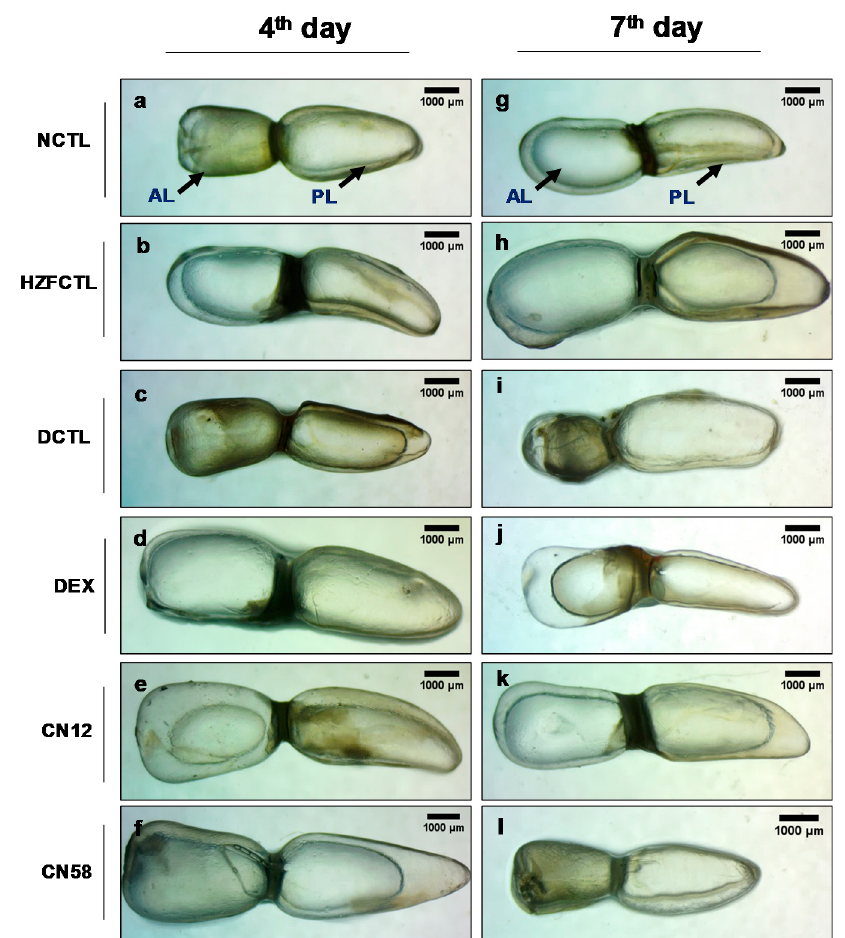
Figure 4. Coronil reduces SARS-CoV-2 induced swim bladder structural abnormality and edema. (Normal control at 4th day ( a ), HZFCTL at 4th day ( b ) and NCTL at 7th day ( g ), HZFCTL at 7th day ( h )) NCTL and HZFCTL at the 4th and 7th day time points, respectively, showing normal swim bladder. ( c , i ) SARS-CoV-2 spike protein induced structural anomaly and edema. ( d ) DEX treatment at the 4th day time point showed mildly inflated swim bladder. ( j ) DEX treatment at the 7th day time point showed narrowing of the posterior lobe due to edema. ( e , f ) At the 4th day time point, the CN12 and CN58 groups were comparable to the NCTL and HZFCTL groups. ( k , l ) At the 7th day time point, the CN12 and CN58 groups were comparable to NCTL. n = 24 for each test group, AL—anterior lobe, PL—posterior lobe. Circle inside the swim bladder indicates the watermark at the contact between the glass slide and swim bladder during the image capturing process. Scale bar, 1000 µ m at 1X magnification.